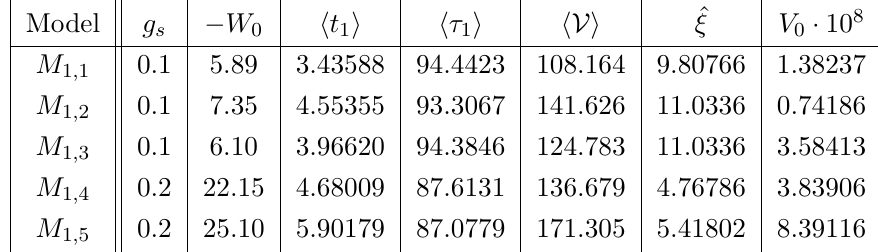
Table 11 . For all CICYs with h 1 , 1 = 1 , we present the α 0 -uplifted stable dS vacua lying in a relatively larger volume regime. The underlying parameters are set as a and the axion ρ is minimized at h ρ 1